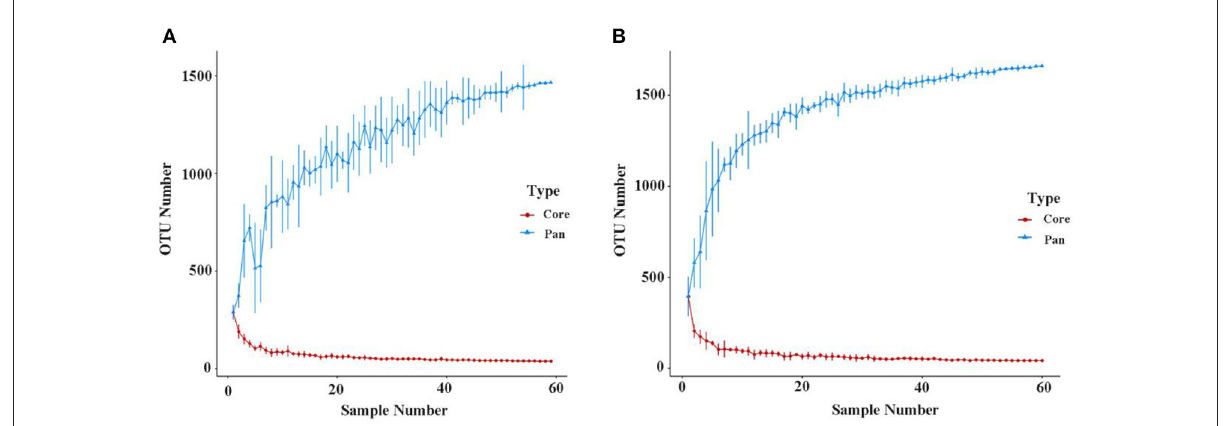
FIGURE2 Pan/Core OTU species analysis of the oral (A) and gut microbiomes (B) . The Pan/Core plot reflects the rate of emergence of species under continuous sampling. The curve flattens out as the sample size increases, indicating that species don’t increase significantly with sample size.